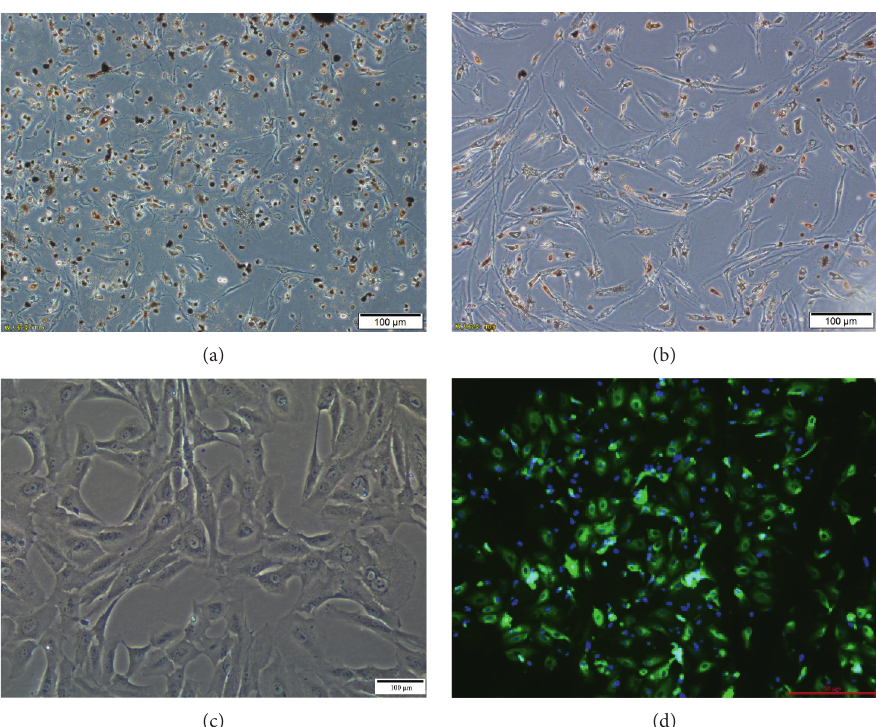
Figure 1: Human RPE cells and immunohistochemistry. (a) After being cultured for 3 days, primary human RPE cells were spindle-shaped or polygonal and the cytoplasm was filled with pigment particles. (b) Seven days later, the cells were spindle-shaped or irregular, with round and binuclear nuclei. (c) The third generation of human RPE cells had fewer pigment particles in the cytoplasm and presented as spindles or irregular polygons. (d) Primary mouse anti-human RPE65 antibodies and secondary goat anti-mouse IgG antibodies were used to immunostain third-generation RPE cells. Immunofluorescence staining was positive for